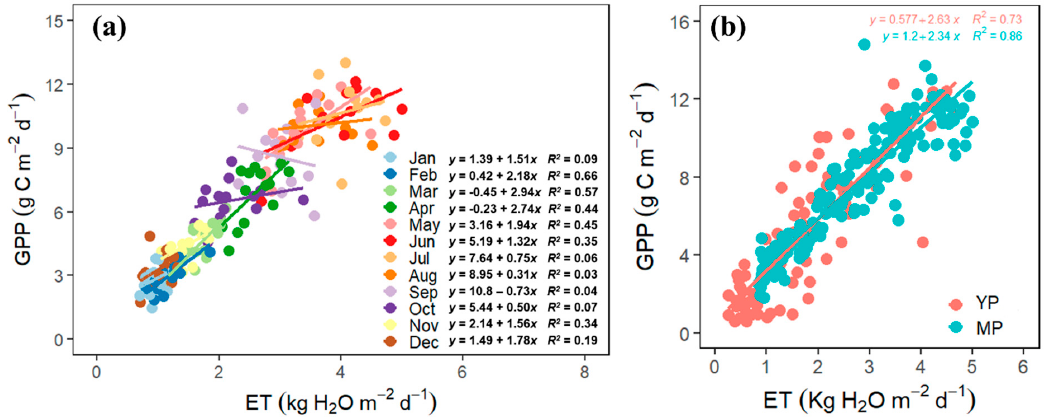
Figure 6. Panel ( a ) is the relationship between evapotranspiration (ET) and gross primary productivity (GPP) across all years in YP and MP with season as a factor. Panel ( b ) is the ET–GPP relationships across the entire period with site as a factor. Each circle indicates the monthly ET and GPP colors according to month ( panel a ) and site ( panel b ). The color line indicates the regression line.